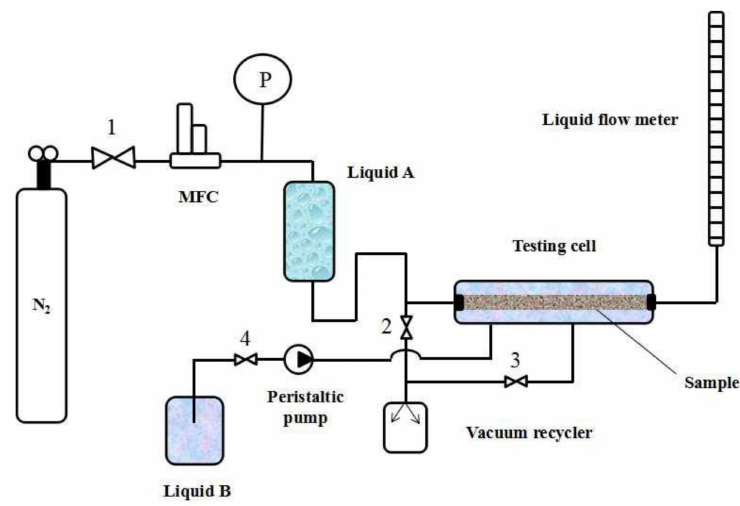
Figure 4. Schematic of apparatus for MLLDP measurements of a single-channel membrane. MFC, mass flow controller. PI, pressure indicator.